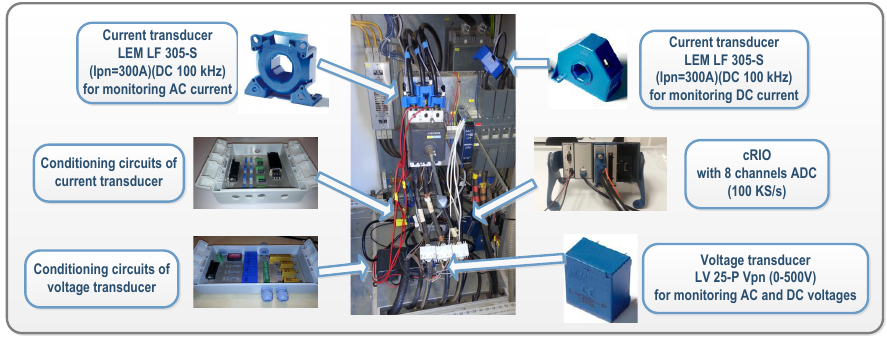
Figure 7. Electrical measurements performed in inverters in grid-connected PV